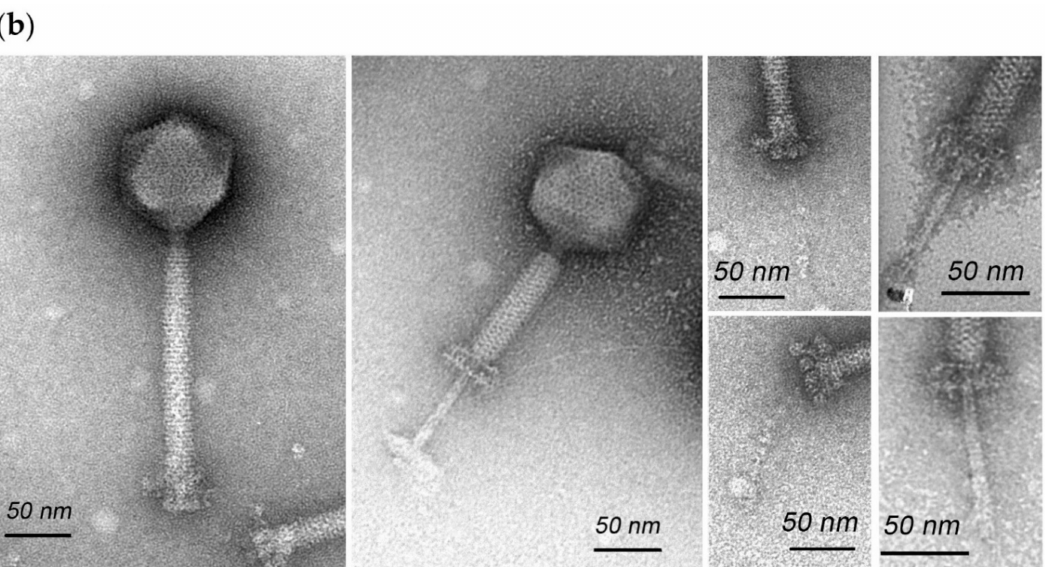
Figure 1. ( a ) Morphology of Enterococcus phage iF6 plaques on a lawn of the E. faecium FS86 strain. ( b ) Transmission electron microscopy of Enterococcus phage iF6 virions with uncontracted (left virion) and contracted (right virion) tails. Virions are negatively stained with 1% ( w / v ) uranyl acetate. Scale bar is 50 nm.